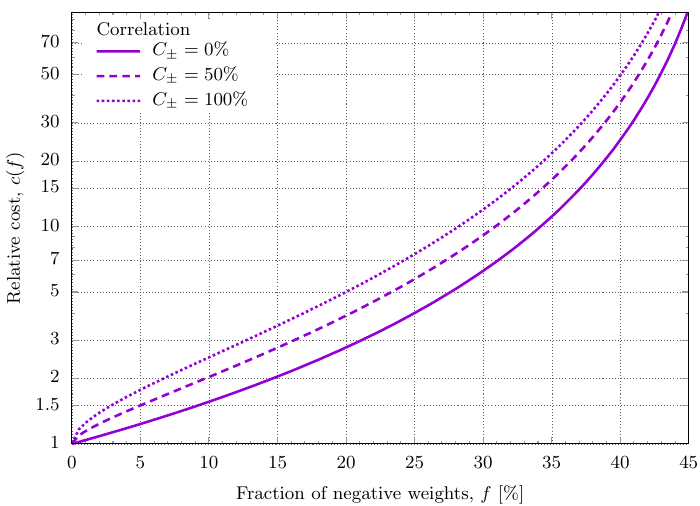
Figure 1 . Relative cost as a function of the fraction of negative weights, eq. (1.6), for three di(cid:11)erent values of the correlation parameter C (cid:6)